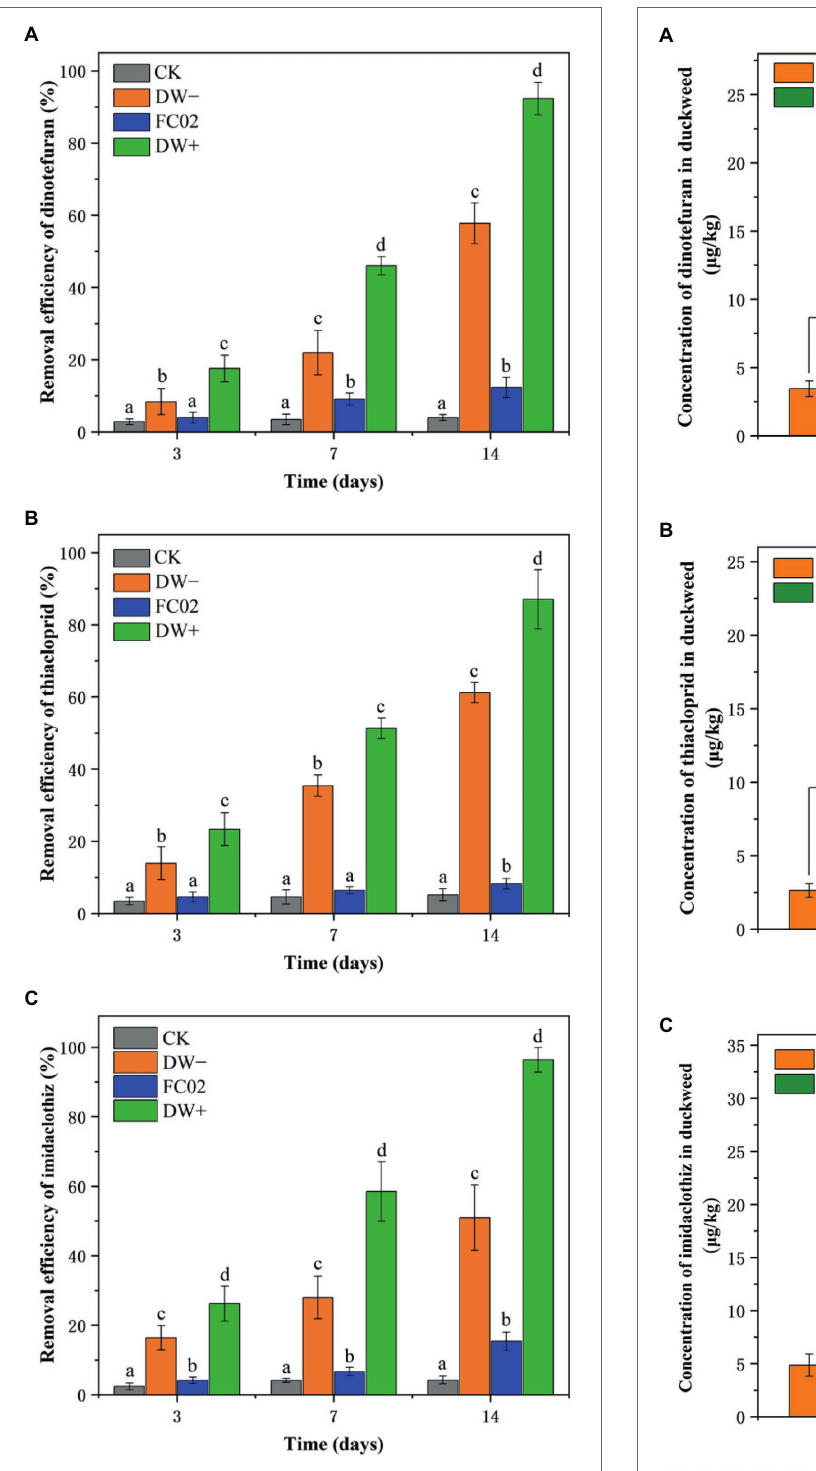
FIGURE 5 | Removal efficiencies of dinotefuran (A) , thiacloprid (B) , and imidaclothiz (C) by duckweed and strain FC02. Treatments: CK, no duckweed and FC02; DW − , uninoculated duckweed; FC02, strain FC02 alone; DW+, duckweed inoculated with stain FC02. Error bars indicate the standard deviations ( n = 3). Different letters indicate significant differences at p < 0.05 by Tukey’s test.